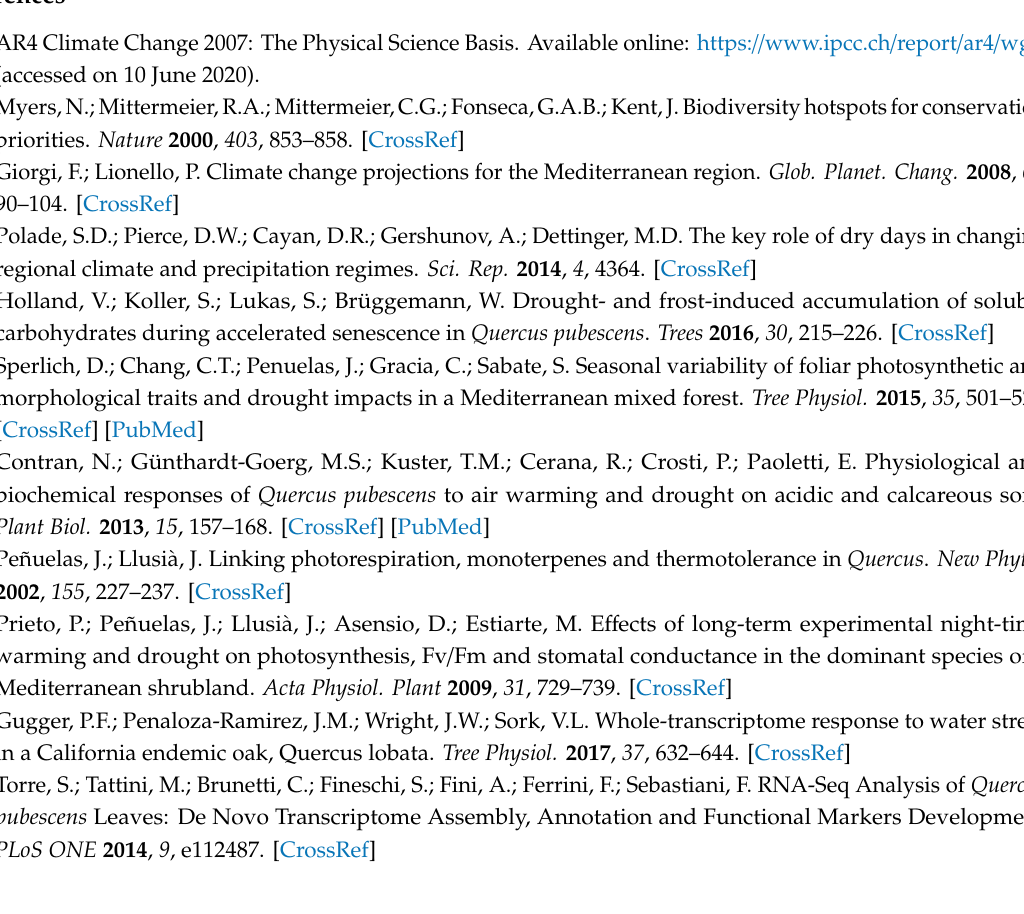
Figure S1: O 3 HP soil water status taking into account the di ff erent sampling dates. Figure S2: Di ff erential transcripts of leaves of Quercus pubescens annotated from an NCBI Blastn search: (a) spring and (b) summer. Blue, upregulated features; red, downregulated features. Table S1: Quercus pubescens genes or contigs di ff erentially expressed during rain exclusion